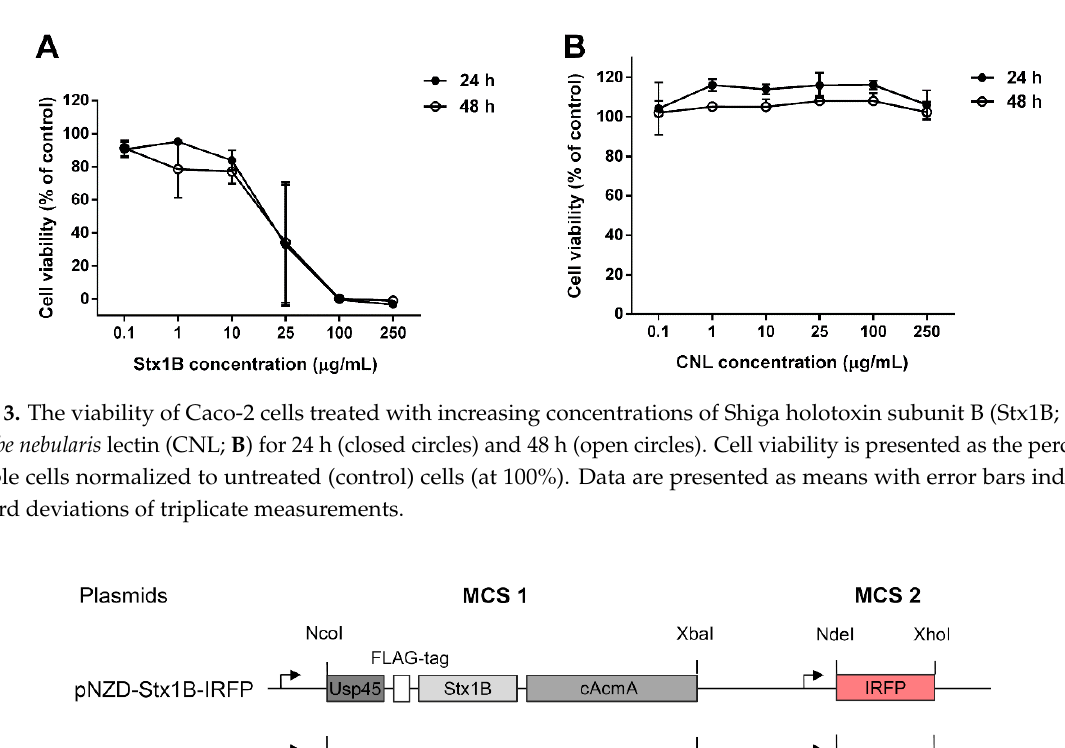
Figure 3. The viability of Caco-2 cells treated with increasing concentrations of Shiga holotoxin subunit B (Stx1B; A ) and Clitocybe nebularis lectin (CNL; B ) for 24 h (closed circles) and 48 h (open circles). Cell viability is presented as the percent- age of viable cells normalized to untreated (control) cells (at 100%). Data are presented as means with error bars indicating standard deviations of triplicate measurements.